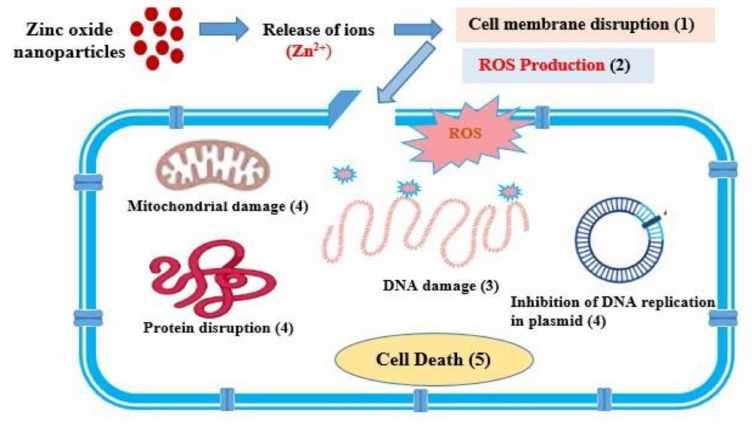
Figure 11. Antimicrobial mechanism of ZnO-NPs.